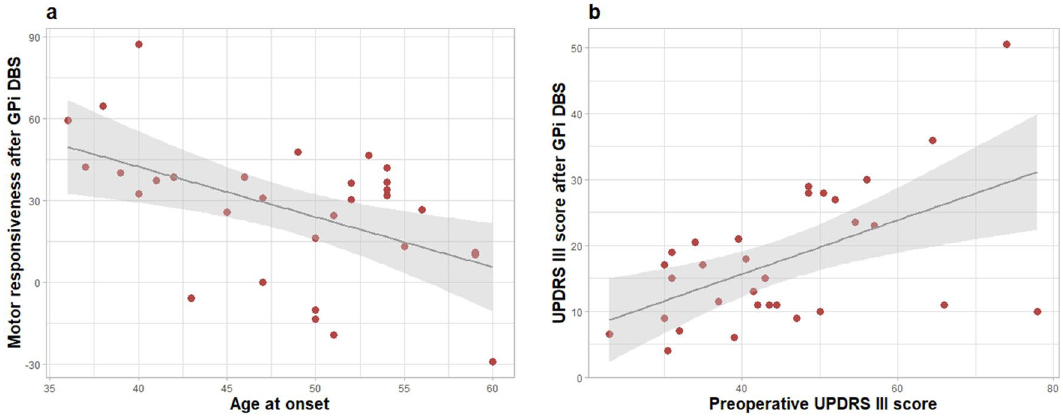
Figure 1. ( a ) Scatter plot of age at onset of PD and motor responsiveness 12 months after GPi DBS. There is a negative linear relationship beteween these two variables. Pearson’s r = −0.50, p = 0.004. ( b ) Scatter plot of preoperative UPDRS III in the medication off state and postoperative UPDRS III in the medication on stimulation on state 12 months after GPi DBS. There is a positive linear relationship between these two variables. Pearson’s r = 0.53, p = 0.002. The correlation is significant at a 0.05 level. PD = Parkinson’s disease, GPi = Globus pallidus interna, DBS = Deep brain stimulation, UPDRS = Unified Parkinson’s Disease Rating